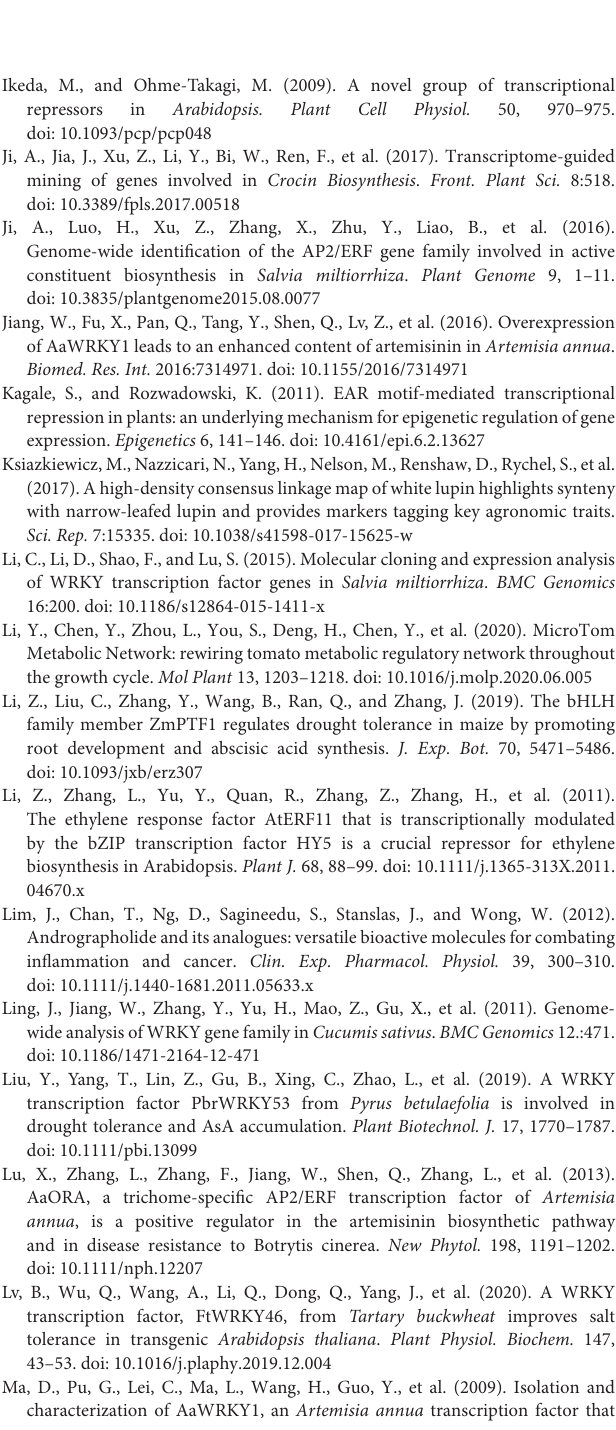
Supplementary Figure 2 | Phylogenetic analysis of candidate WRKYs and functional WRKYs from other species. Supplementary Table 1 | Primer sequences of the candidate WRKYs used for qRT-PCR analyses. Supplementary Table 2 | Complete list of WRKY transcription factors identified in the A. paniculata genome.